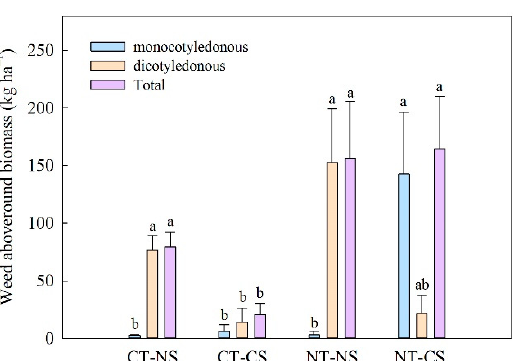
Figure 5. The aboveground weed biomass before wheat harvesting under conventional tillage with no crop residue (CT-NS), conventional tillage with crop residue (CT-CS), no-till with no crop residue (NT-NS), and no-till with crop residue (NT-CS). Different letters indicate significant difference among treatments (one-way ANOVA, p < 0.05). Bars represent means ± SE.